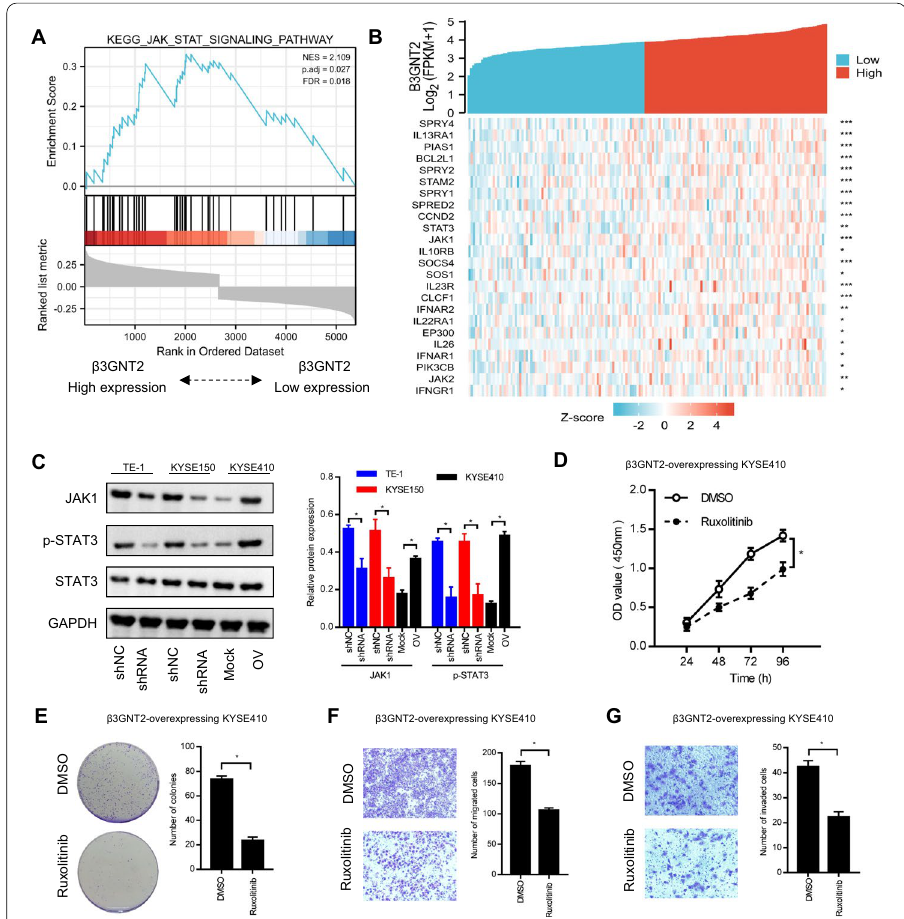
Fig. 6 The JAK-STAT pathway is regulated by β3GNT2 in ESCA. A GSEA plot showing a positive correlation between β3GNT2 expression and the JAK-STAT pathway. B Heatmap showing the Spearman correlation coefficient between β3GNT2 and the JAK-STAT pathway-related genes in ESCA. Asterisks represent the significance of the Spearman correlation. C Analysis of the JAK-STAT pathway-related protein expression by Western blot. D – G The effect of ruxolitinib on cell proliferation, colony formation, migration, and invasion was determined by CCK-8 assay ( D ), colony formation assay ( E ), Transwell migration assay ( F ), and Matrigel invasion assay ( G ). Cells were transfected with the indicated plasmids. shNC, negative control shRNA; shRNA, β3GNT2 shRNA2 lentiviral vector; Mock, empty plasmid; OV, pcDNA3.1/β3GNT2 plasmid. Data are expressed as mean SD. *P < 0.05, **P < 0.01, ***P < ±